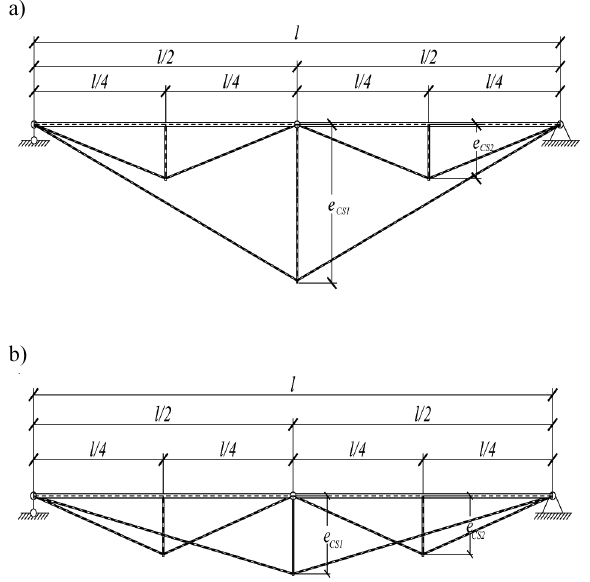
Fig. 1. Structural schemes for the under-deck cable-stayed brid- ge with the a) framing first level cable-staying system; b) passing first level-cable staying